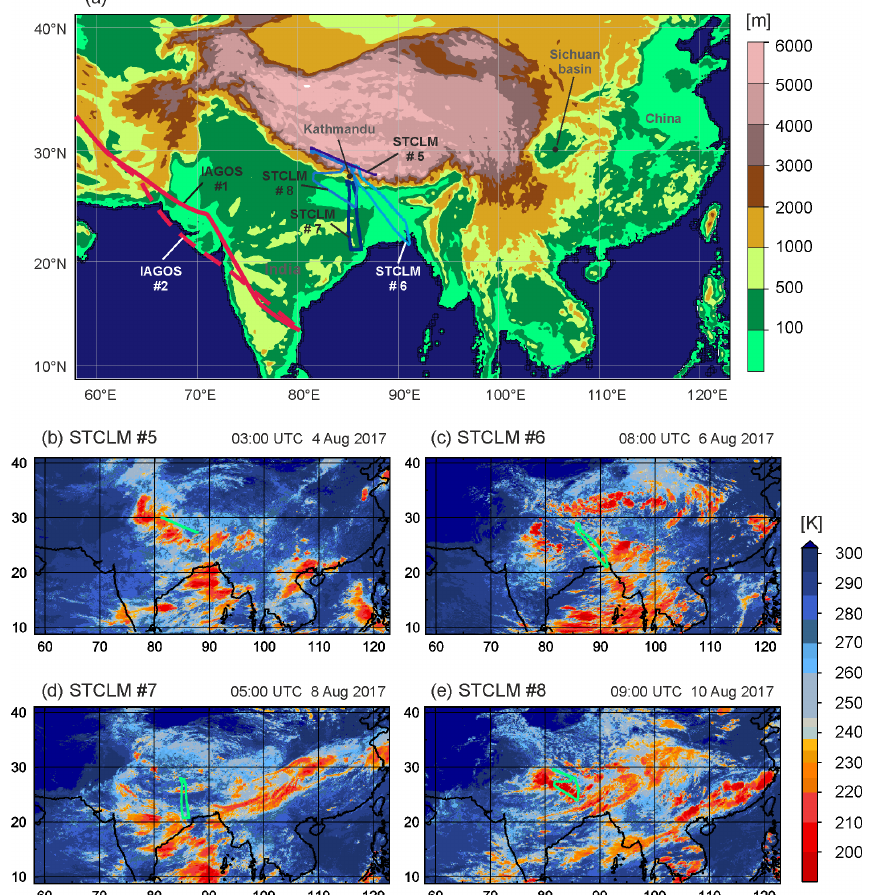
Figure 1. (a) Topography and domain considered in the Meso-NH numerical simulation with a resolution of 15km. The trajectory of the Geophysica flights #5–#8 during the StratoClim campaigns (indicated by STCLM) around and south of Kathmandu are shown by the bluish solid lines in (a) , while the trajectory is displayed by green solid lines and overlapped on BT distribution at the time around each flight’s departure in (b–e) , respectively. In (a) , two IAGOS flight tracks (to and from Madras in India) are indicted by the red solid and dashed